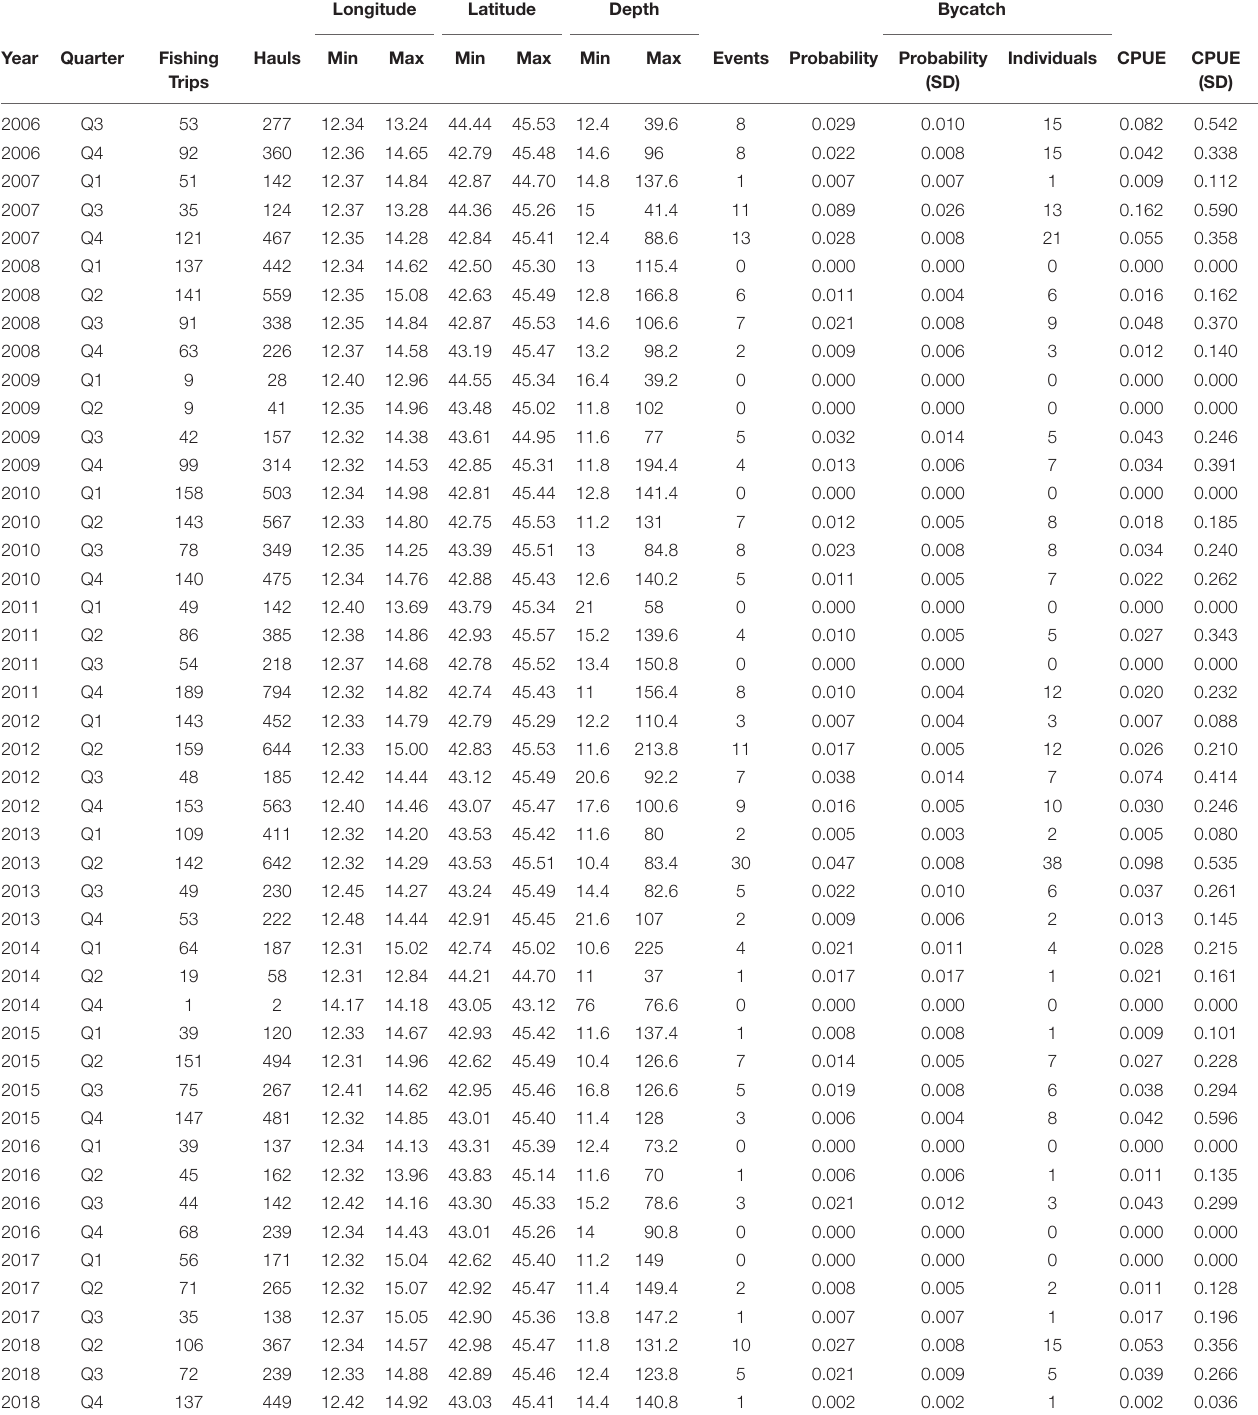
TABLE 1 | Summary table of the dataset used in the